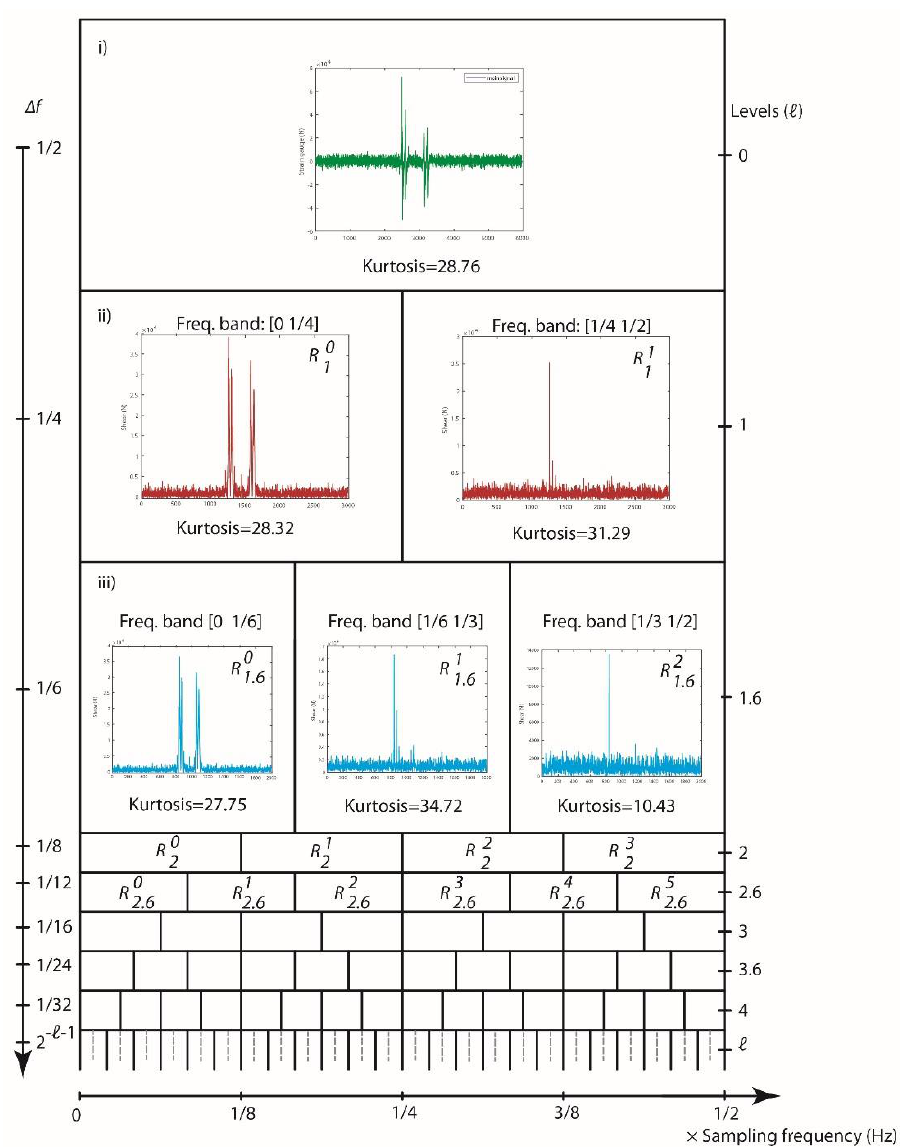
Figure 7. Framework to obtain the kurtogram, the central frequency, and the frequency band for each signal.